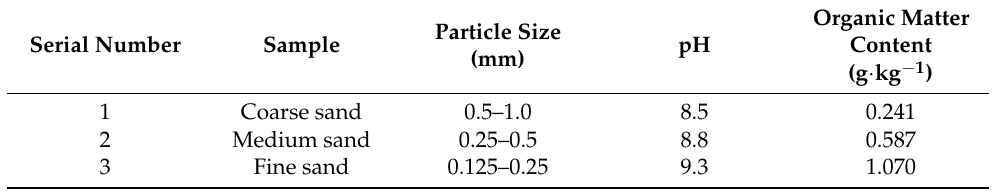
Figure 1. Location of sampling points. Table 1. Soil particle composition and its parameters.